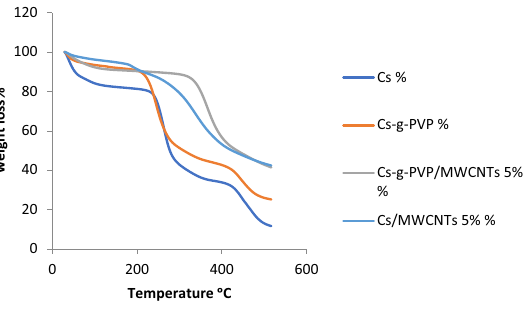
Figure 4. Thermogram of Cs, Cs-g-PVP, Cs-g-PVP/f-MWCNTs(5wt%) and Cs/f-MWCNTs(5wt%).